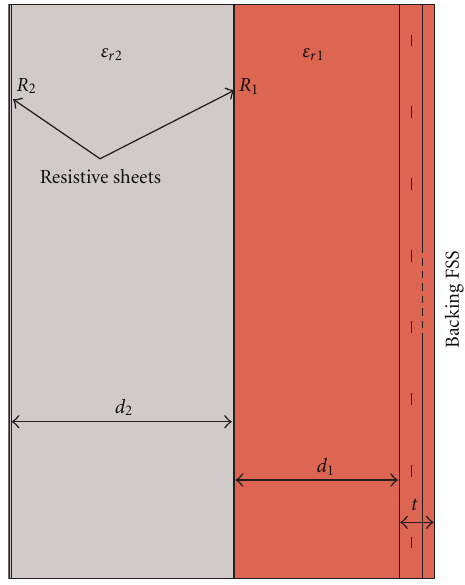
Figure 4: The cross-section of the FSS-backed Jaumann absorber.